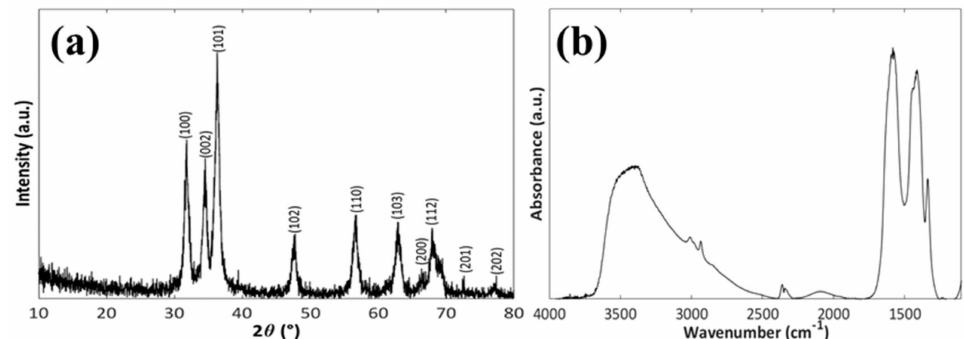
Figure 4. XRD pattern ( a ) and FTIR spectrum ( b ) of the mesoNsZnO carrier.